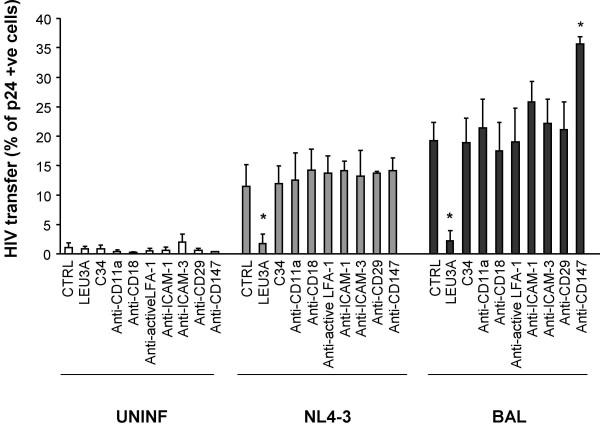
The role of adhesion molecules on T cell-to-T cell HIV transmission. Blocking antibodies against the indicated cell surface molecules were used to inhibit the transfer of HIV particles after 2 h of coculture of primary CD4 T cells with uninfected MOLT (white bars), MOLT NL4-3 (grey bars) or MOLT BaL cells (dark bars). Concentrations were 10 μg/mL for all mAbs against cell surface molecules, except for Leu3a (5 μg/mL) and C34 (1 μg/mL). Data are Mean ± SD of 3 independent experiments employing cells of 3 different donors. Asterisks indicate a significant inhibition in HIV transmission in the presence of Leu3a.